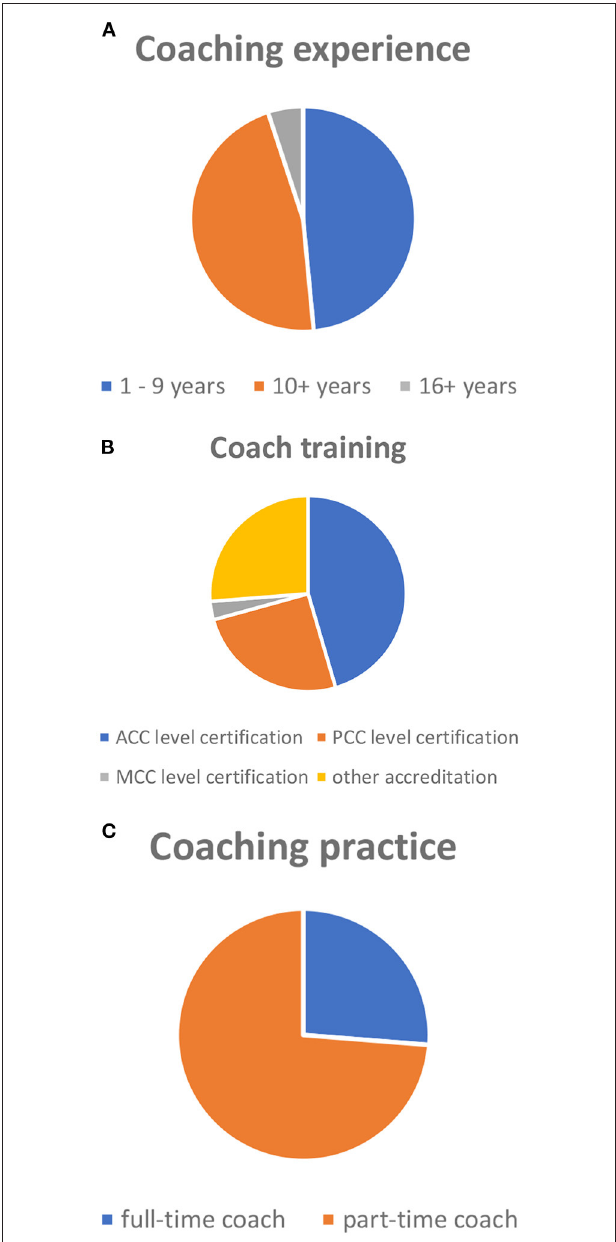
FIGURE 6 | (A) Coach participation based on level of experience. Coaching experience prior to enrollment was defined by three categories: 1–9 years, 10 + , and 16 + years. (B) Coach participation based on level of training. Coaching training requirements as based on ICF’s (International Coaching Federation) certification levels: ACC level certification requires 60 + h of coach-specific training and 100 + h of coaching experience; PCC level certification requires 125 + h of coach-specific training and 500 + h of coaching experience; MCC level certification requires 200 + h of coach-specific training and 2,500 + h of coaching experience. “other accreditation” refers to any other coach-specific training outside ICF’s scope of accreditation. (C) Coach participation based on level of coaching practice. Coaching training requirements as based on coaches’ full-time or part-time professional